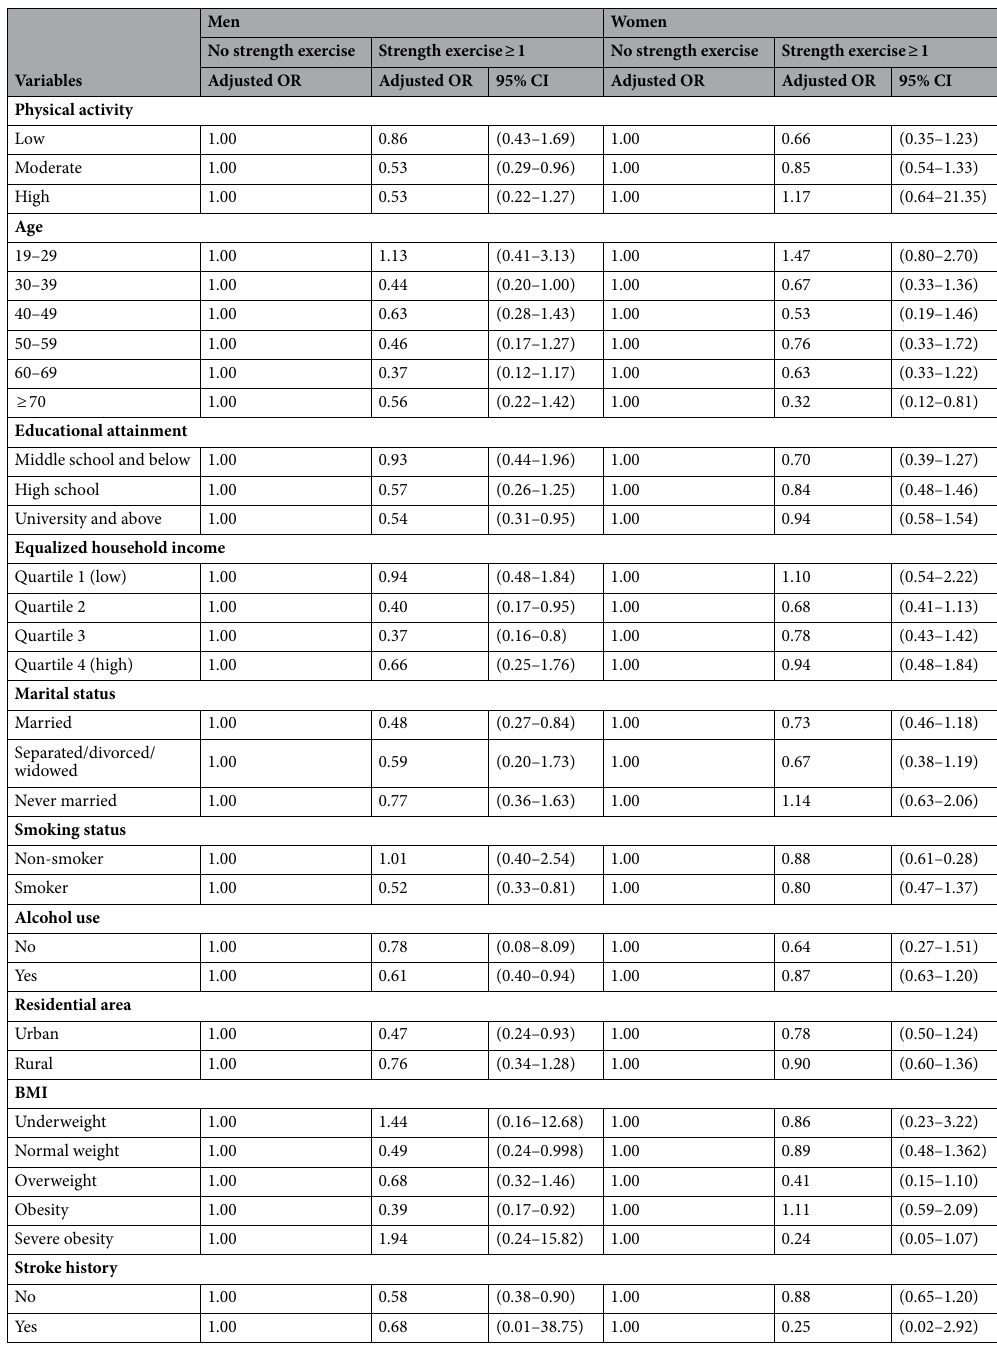
Table 3. Subgroup analysis of the association between strength exercise and depression stratified by sociodemographic variables. PHQ-9 patient health questionnaire-9, BMI body mass index, Underweight BMI < 18.5, Normal weight 18.5 ≤ BMI < 23, Overweight 23 ≤ BMI < 25, Obesity 25 ≤ BMI < 30, Severe obesity 30 ≤ BMI, OR odds ratio, CI confidence